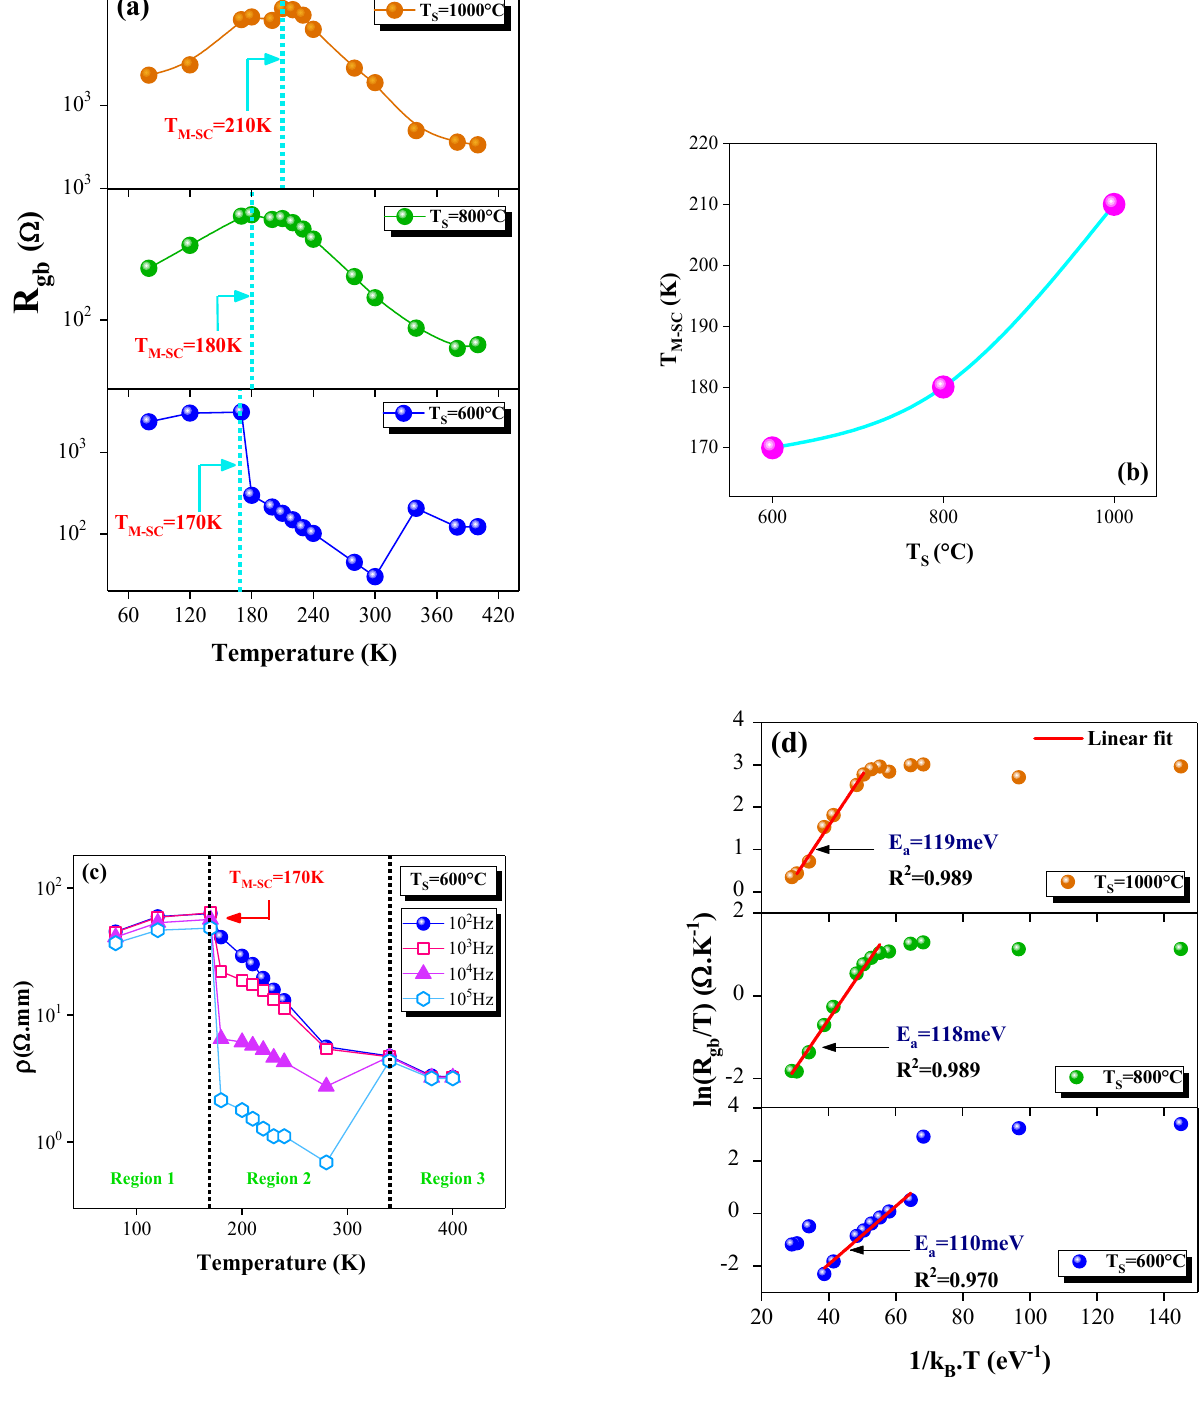
Figure 5. Temperature dependence of the grain boundary resistance for the La 0.9 Sr 0.1 MnO 3 compound at different sintering temperatures ( a ). Evolution of T M-SC with sintering temperature T S ( b ). Temperature dependence of the electrical resistivity for the sample sintered at 600 °C performed at different frequencies ( c ). Plot of ln(R gb /T) against (1/k B × T) at different sintering temperatures ( d ).